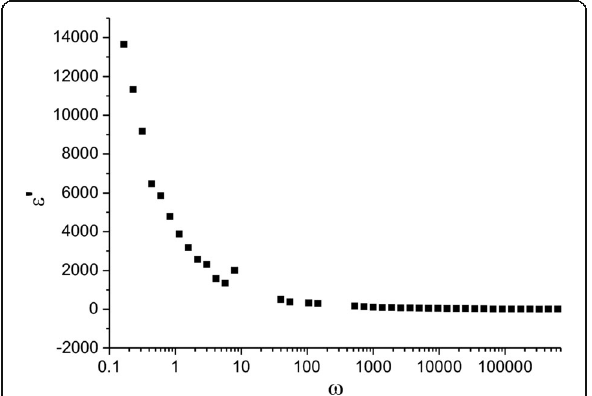
Fig. 10 The dependence of the real part of the conductivity on frequency